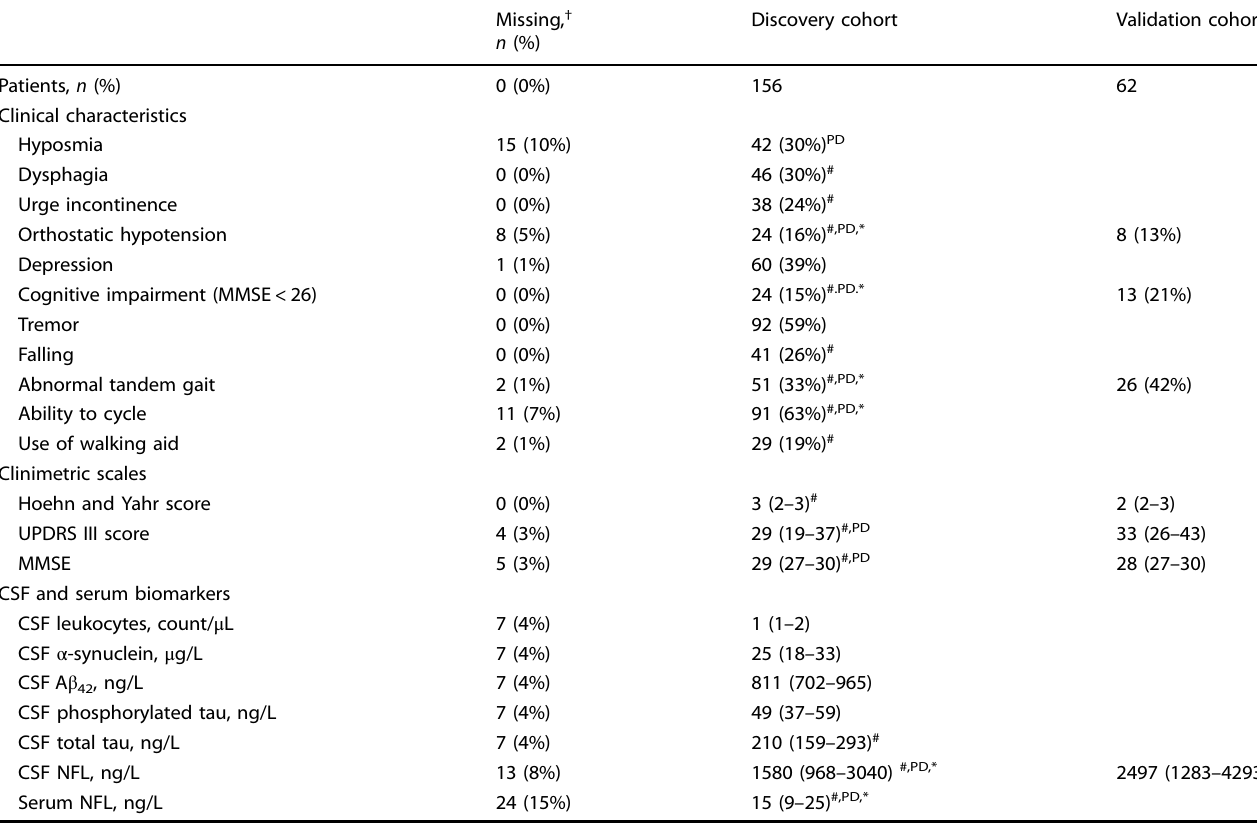
Table 2. Possible predictors of survival in discovery and validation